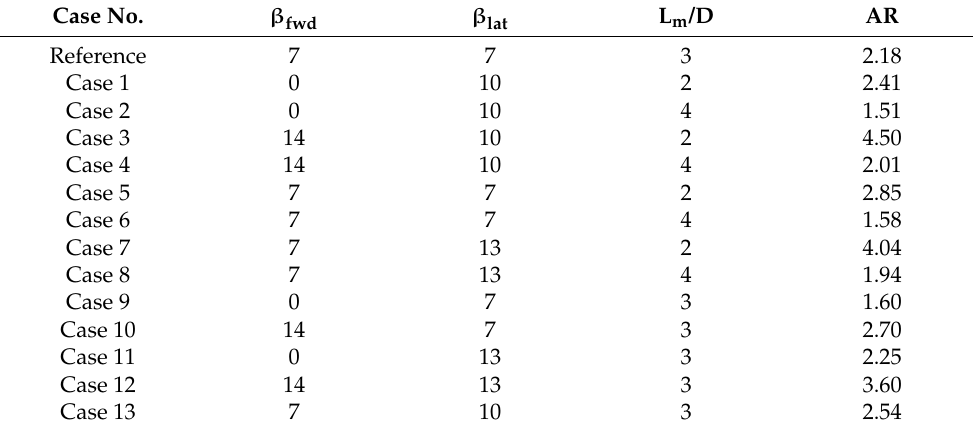
Table 1. Fan-shaped holes dimensions [14]. Reprint with permission from Elsevier (License